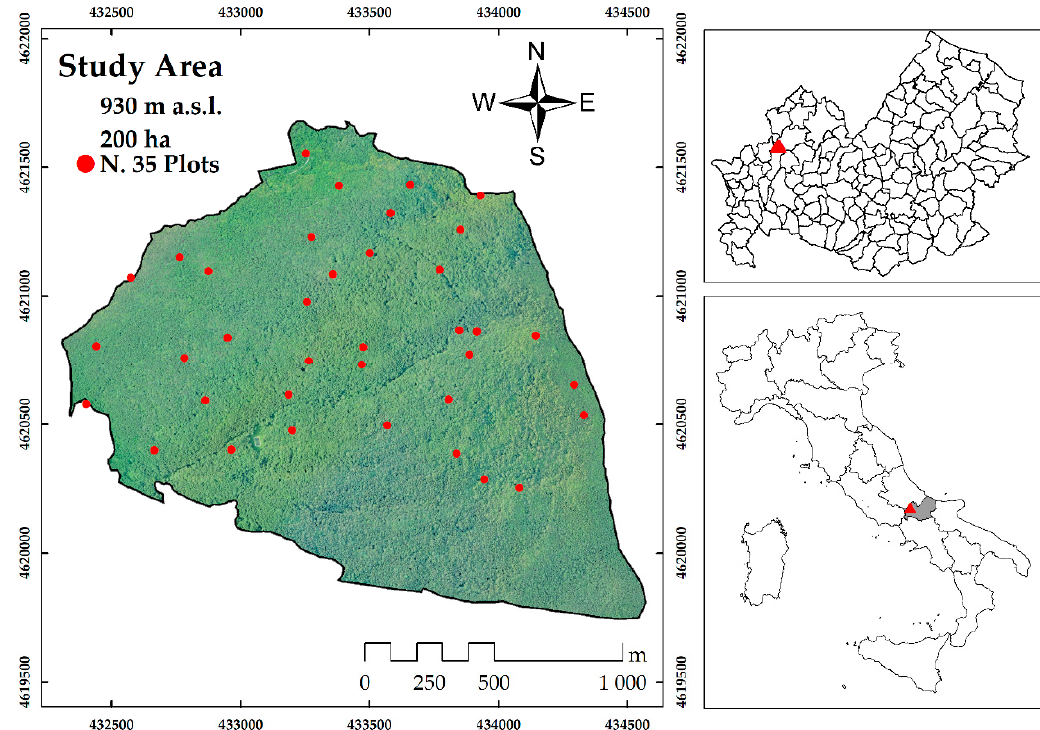
Figure 1. Study area. Geographical distribution of field plots within which forest inventory variables were collected. The sampling scheme was developed under the project FRESh LIFE using the one-per-stratum stratified sampling scheme [31].